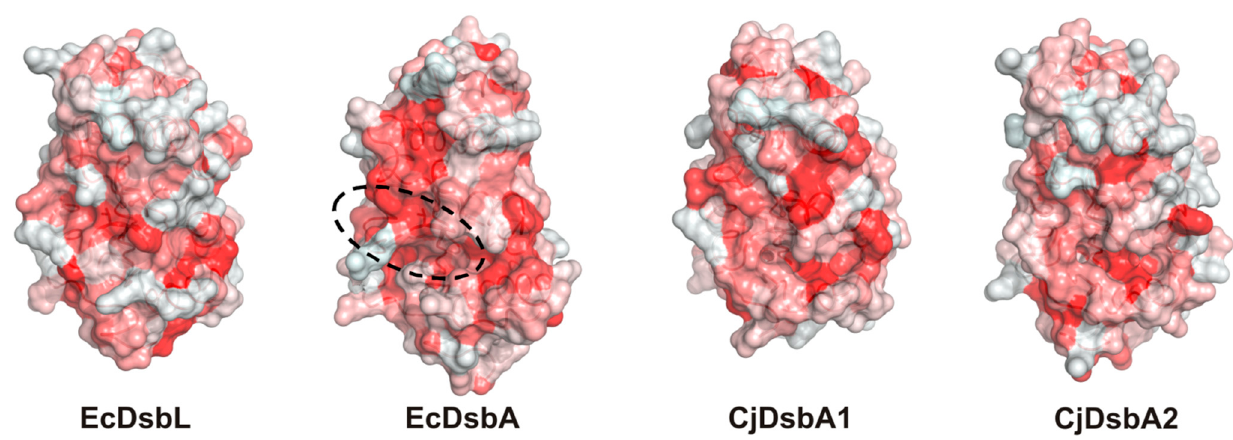
Figure 10. Comparison of surface hydrophobicity of selected Dsb enzymes. All structures shown in the same orientation. The EcDsbB peptide binding site is indicated by black dashed ellipse for the EcDsbA model. Red color indicates hydrophobic